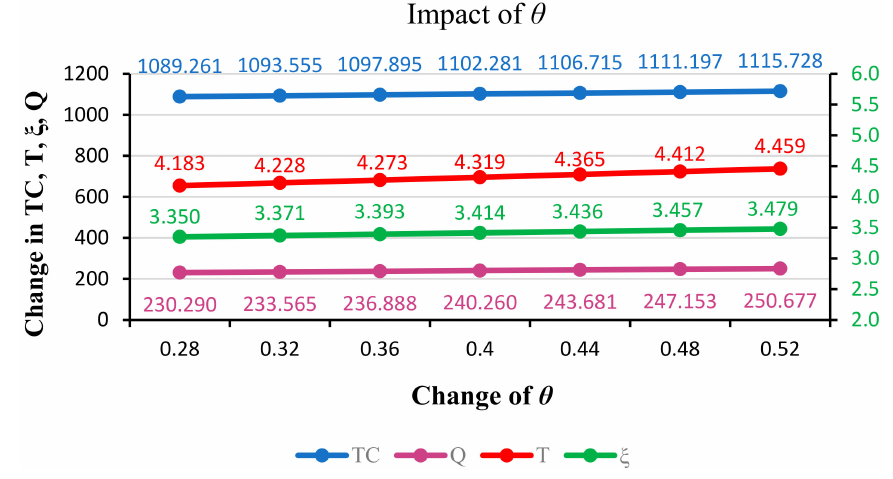
Figure 8. The relationship among θ and TC, T, ξ , Q .